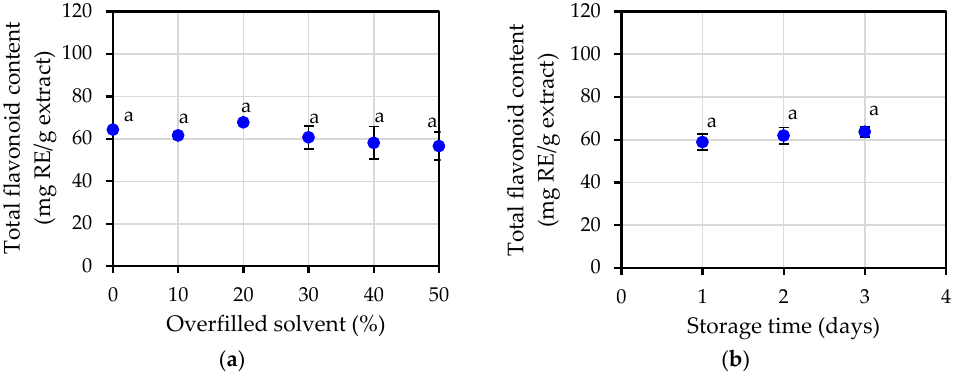
Figure 4. Total flavonoid content of jasmine essential oil: ( a ) at varying percentage of overfilled solvent; ( b ) at varying storage time. The same letters a in the same figure indicate that values are not significantly different ( p < 0.05).